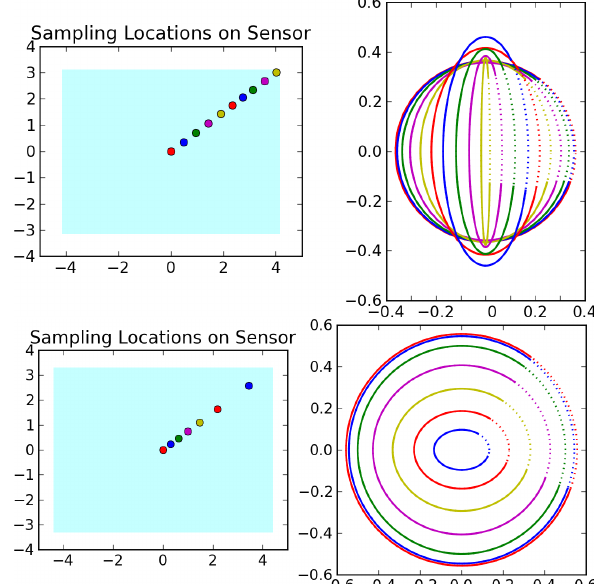
Figure 4: Predicted and Measured Error Ellipses; The top graph shows the Fisheye lens, below is the Catadioptric cam- era. Error Ellipses at 1000mm distance, predicted (dashed lines) by determining the perpendicular and tangential axis distances. Measured (solid lines) by sampling in the image plane with σ = 0 . 1 pixel units, followed by a projection to space. The lo- cation of these samplings is illustrated in the blue area, which represents the camera sensor. Location circles on sensor are ex- aggerated for sake of visibility. All units in mm. cast to 3D space, resulting in a cone shape with its apex at camera center (cid:126)C and its base the elliptical standard deviation.